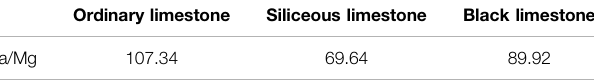
TABLE 5 | Ca/Mg values of collected limestone sample